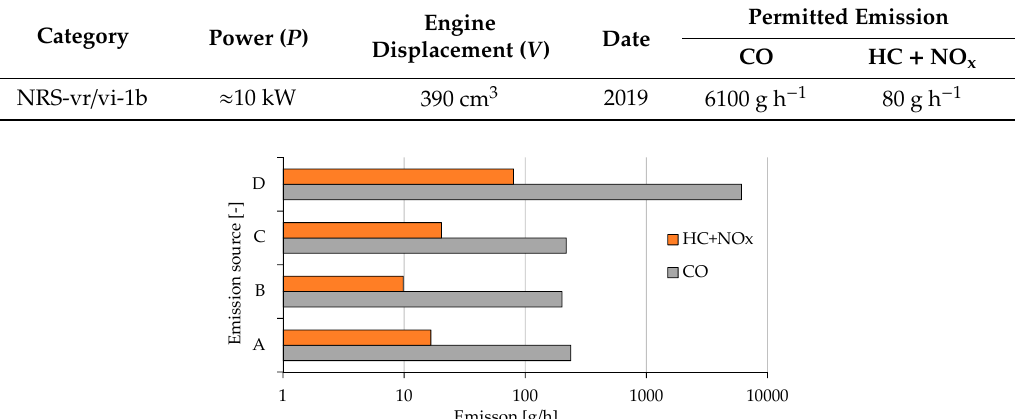
Figure 16. Comparison of emissions; A—Carburettor fuel supply system, B—Injector fuel supply system, C—Injector fuel supply system equipped with an adaptive drive control system, D—Permitted by European standard.